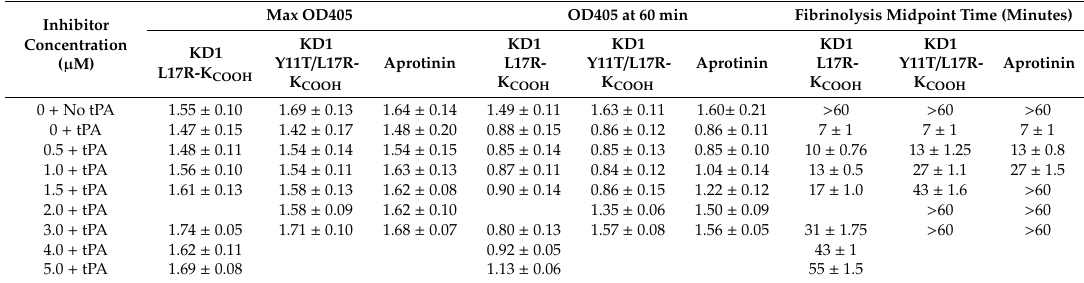
Table 2. The e ff ect of KD1-L17R-K COOH , KD1-Y11T / L17R-K COOH and aprotinin on plasma clot lysis. Inhibitor Concentration